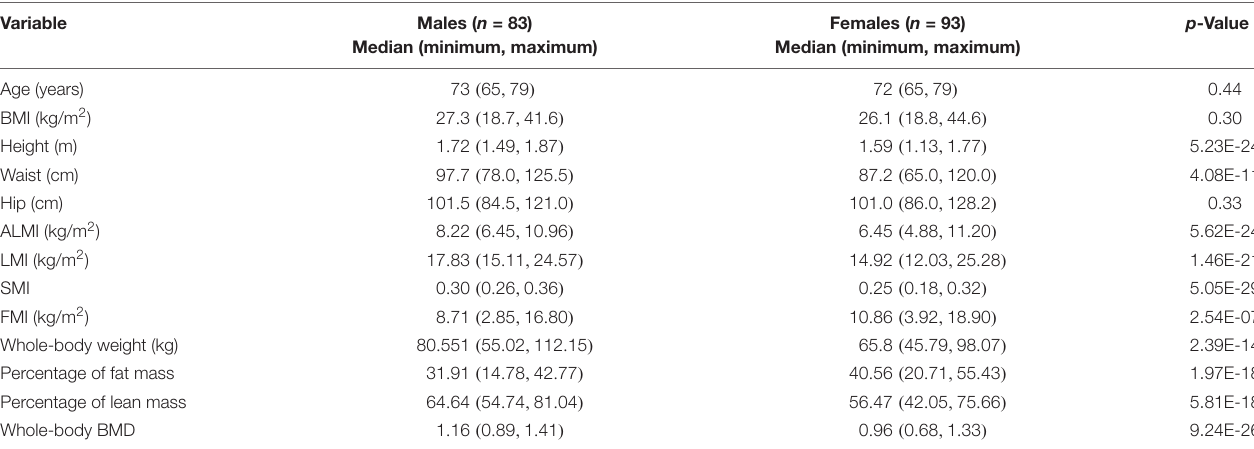
TABLE 1 | Population